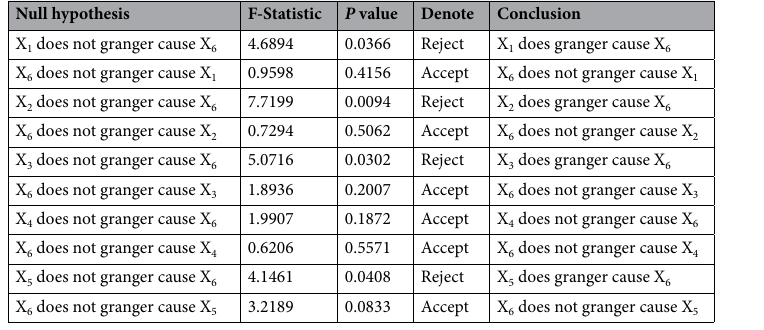
Table 9. Granger causality test results about X 6